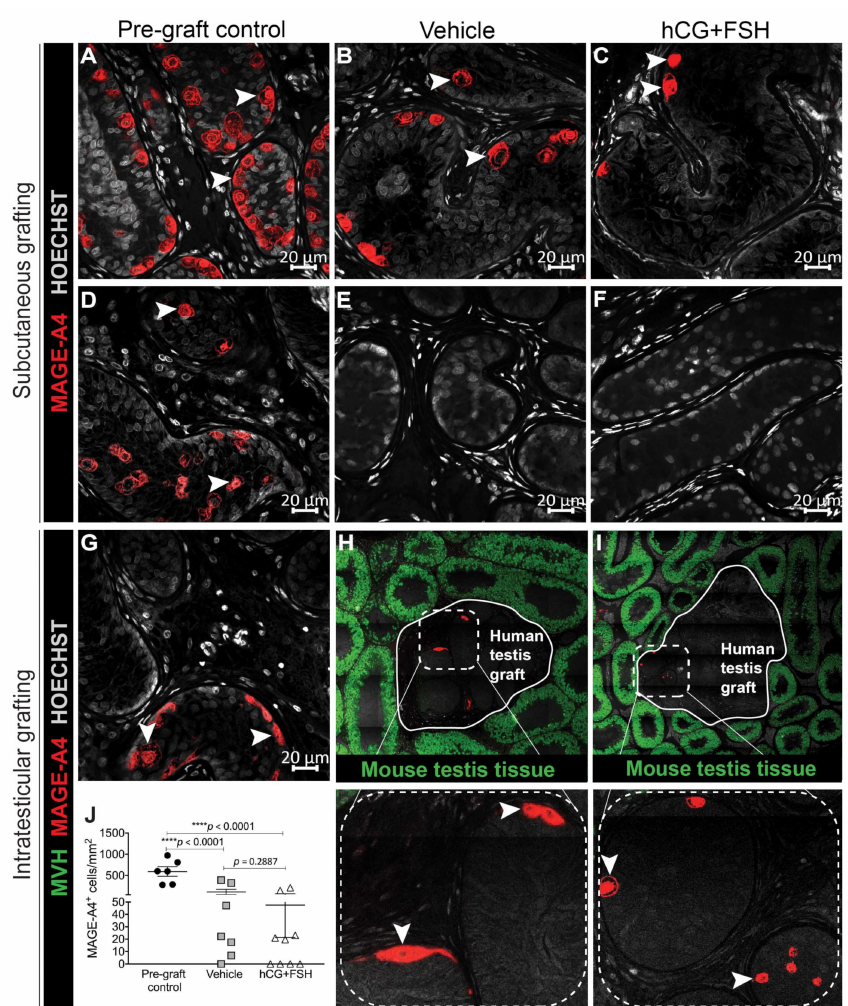
Figure 7. Expression of MAGE-A4 in prepubertal human testis grafts. ( A ) Pre-graft control (1-year-old) and subcutaneous xenografts exposed to ( B ) vehicle or ( C ) gonadotrophins. ( D ) Pre-graft control (14-year-old) and subcutaneous xenografts exposed to ( E ) vehicle or ( F ) gonadotrophins. ( G ) Pre-graft control (14-year-old) and intratesticular xenografts exposed to ( H ) vehicle or ( I ) gonadotrophins with corresponding higher magnification images (bottom images). ( J ) Quantification of human spermatogonia determined as the number of MAGE-A4 + cells per square millimetre. Individual data points represent the number of MAGE-A4 + cells for each pre-graft control and intratesticular graft. Statistical significance was determined using two-way ANOVA. Data are presented as mean ± SEM ( n = 3 prepubertal testis samples per transplantation site). Mouse Vasa Homologue (MVH) is a germ cell-specific DEAD-box type RNA binding protein. MVH + staining identifies mouse germ cells. Arrowheads indicate MAGE-A4 +